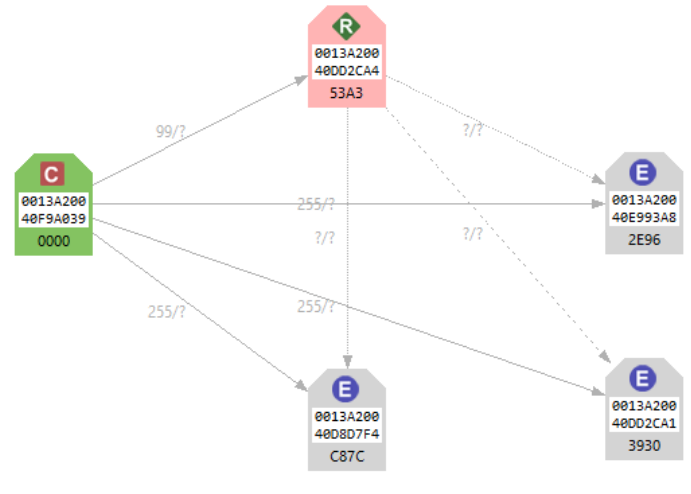
Figure 17. Network topology with an unavailable